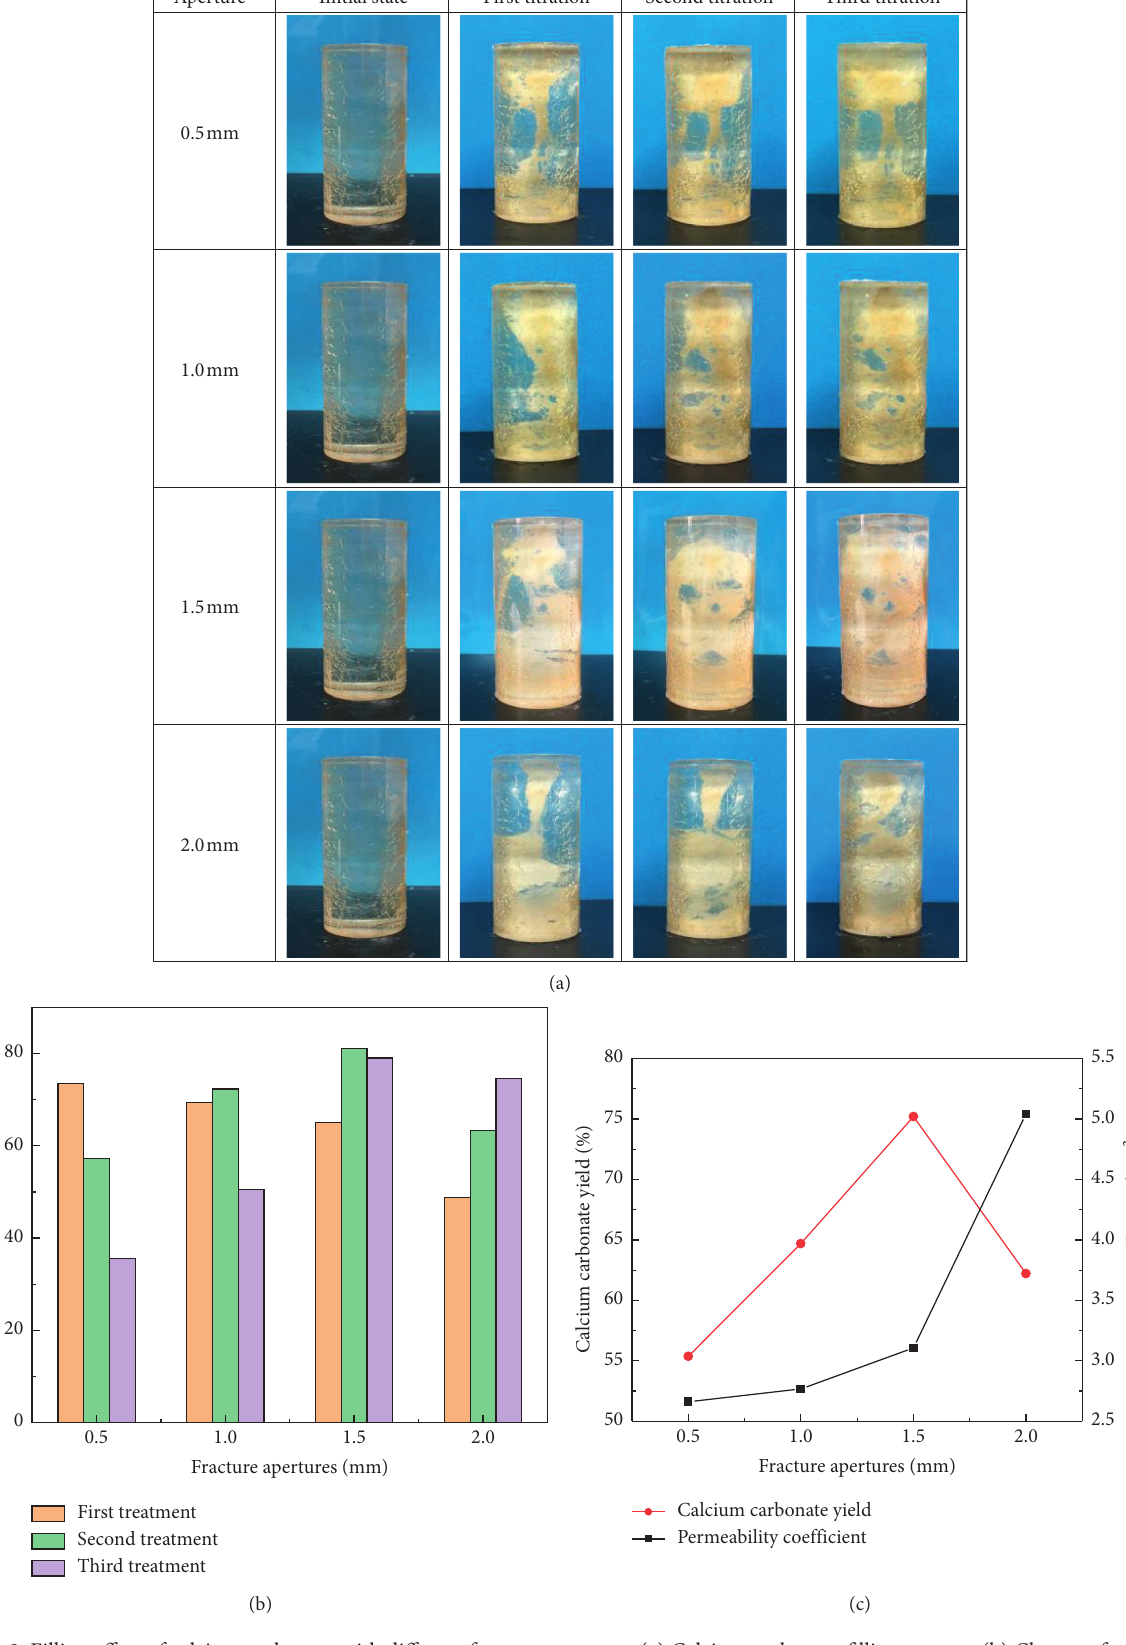
Figure 9: Filling effect of calcium carbonate with different fracture apertures. (a) Calcium carbonate filling process. (b) Change of calcium carbonate content. (c) Change of fracture